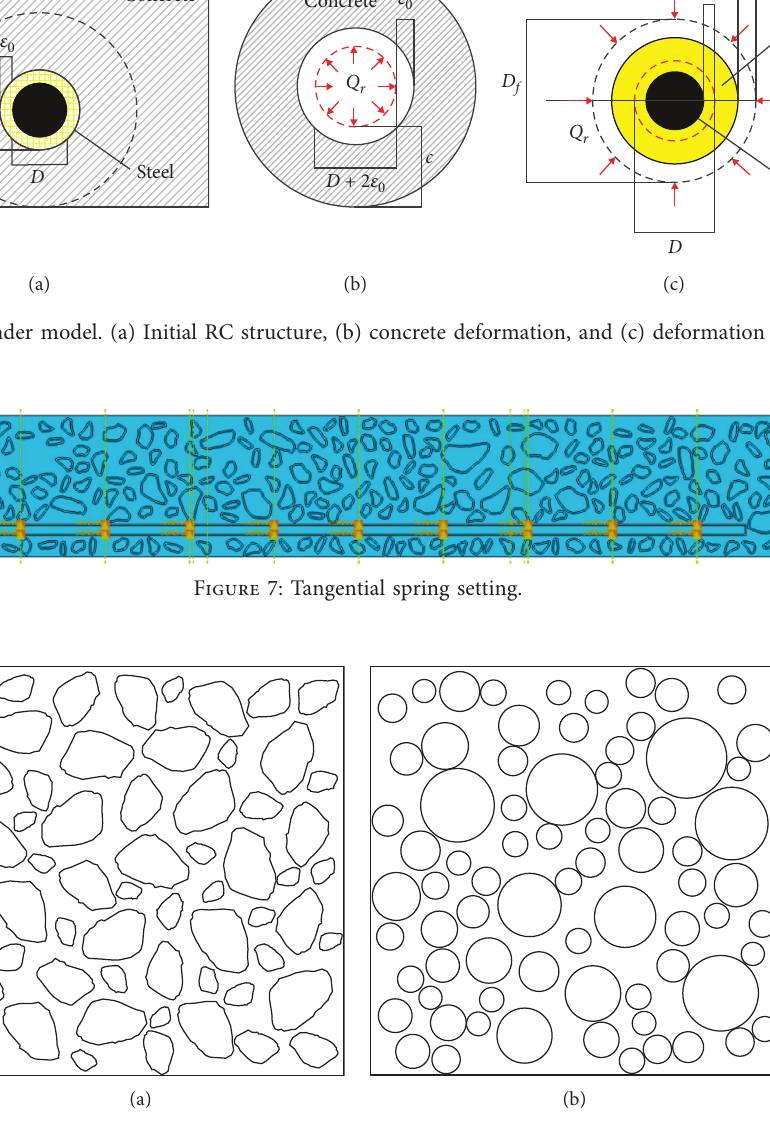
Figure 8: Different aggregates: (a) polygon aggregates and (b) circle